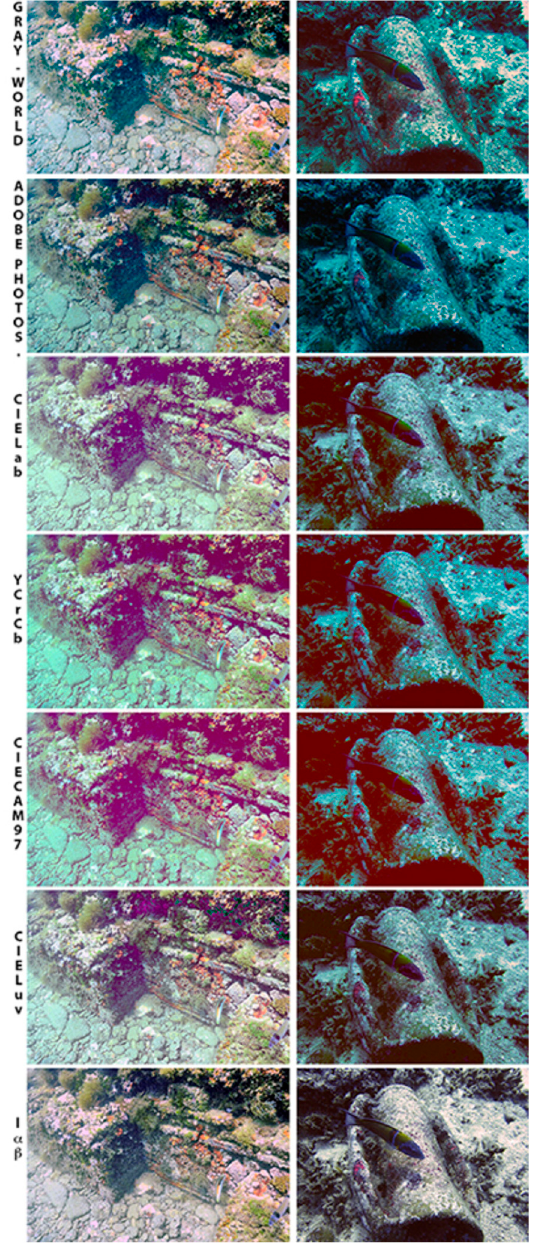
Figure 1. Comparison among different colour correction methods. Image from [24].